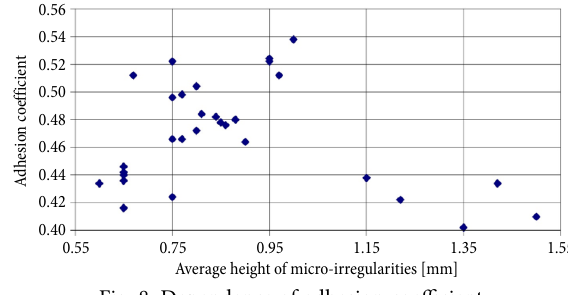
Fig. 8. Dependence of adhesion coefficient on road surface roughness